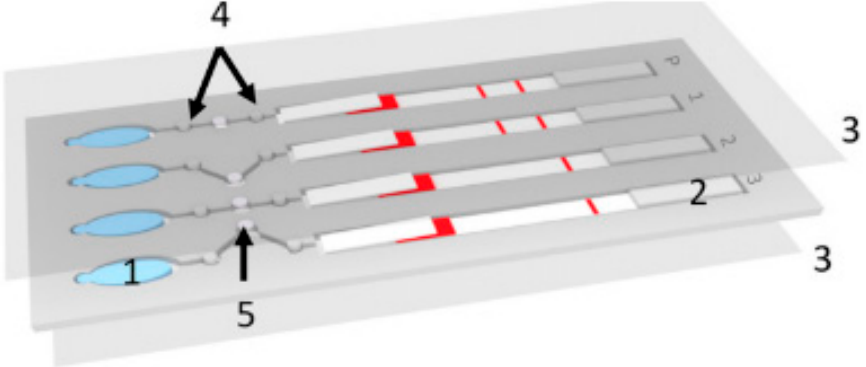
Figure 2. Example of a lateral flow device from Reboud et al. (1) buffer chamber which acts as a pump when pressed. (2) Lateral flow detection strip. (3) Acetate films to cover the device. (4) Filter valves made from paper to prevent the reagents from mixing prematurely. (5) Filter paper for LAMP reaction. Reprinted with permission from [1]. © 2018 National Academy of Sciences.